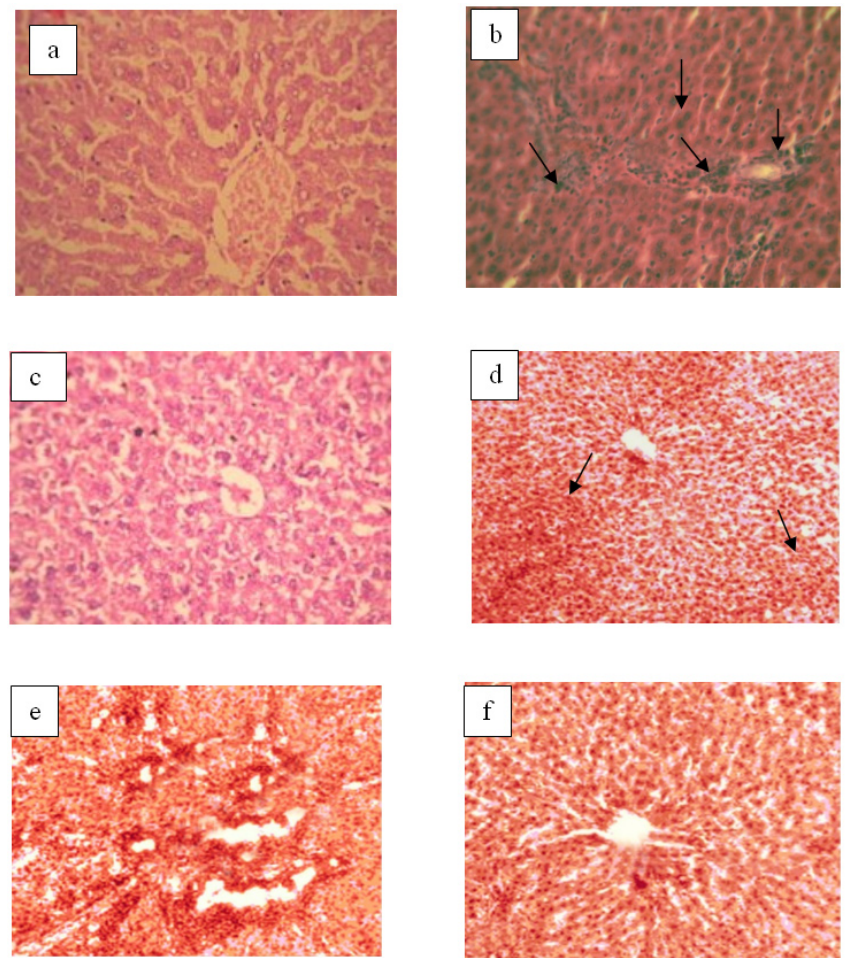
Fig. 2. Histopathological examination of Liver tissues of control and experimental animals: Group I-Normal liver around central vein (a); Group II-Fatty changes and inflammatory cell infiltration (b); Group III-Mild reduction in fatty changes and inflammatory cell infiltration (c); Group IV-Marked reduction in fatty changes and inflammatory cells infiltration (d); Group V-Very mild reduc- tion in fatty changes and inflammatory cell infiltration (e); Group VI-No changes in liver